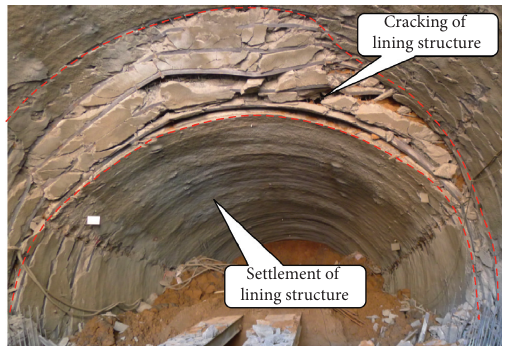
Figure 12: Cracking of the inverted arch.